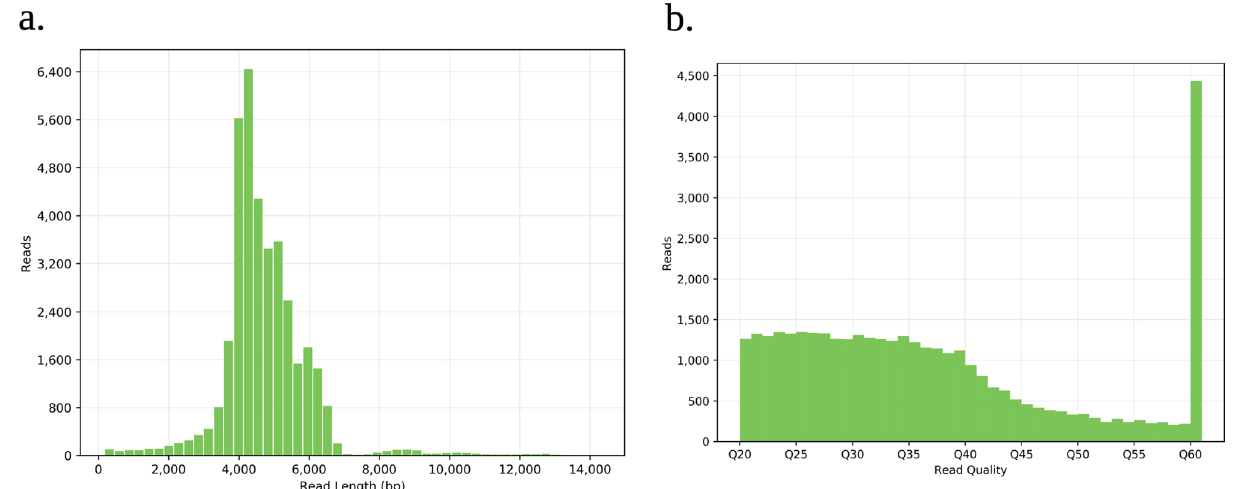
Figure 2. Assessment of the w Di genome. ( a ) and ( b ) Read length and quality assessment for PacBio circular consensus sequences for w Di